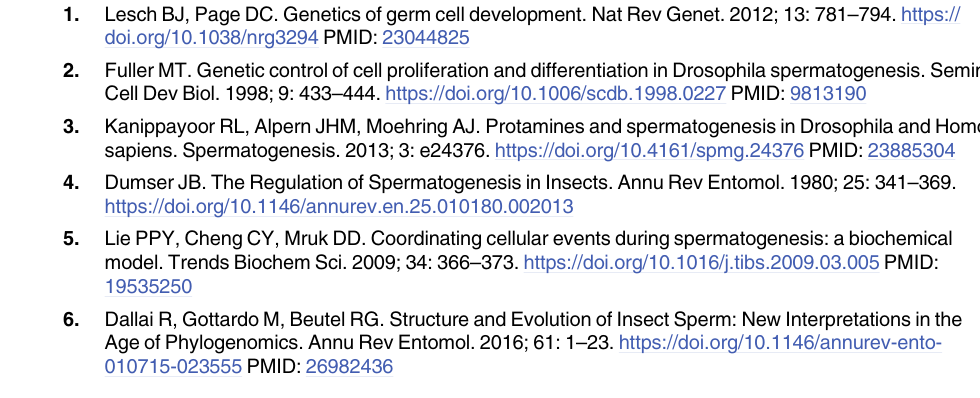
< 0.05. Right: Venn diagram of the number of genes commonly and specifically differentially regulated in testis (green) and sperm (blue) samples of BmPrmt5 mutants and BmVasa mutants relative to WT. The “sperm-specific” DEGs were used for further analysis. Δ BmPrmt5 and Δ BmVasa represent BmPrmt5 and BmVasa mutants,